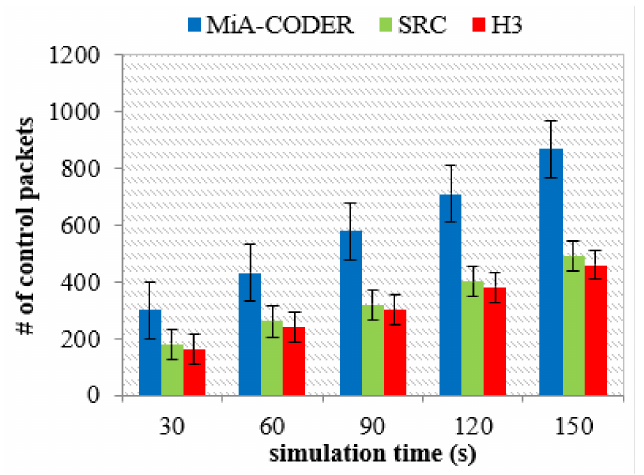
Figure 15. Number of control packets (after coverage hole repair) vs. simulation